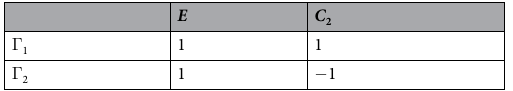
Table 3. Character table of the point group 2 ( C 2 ).